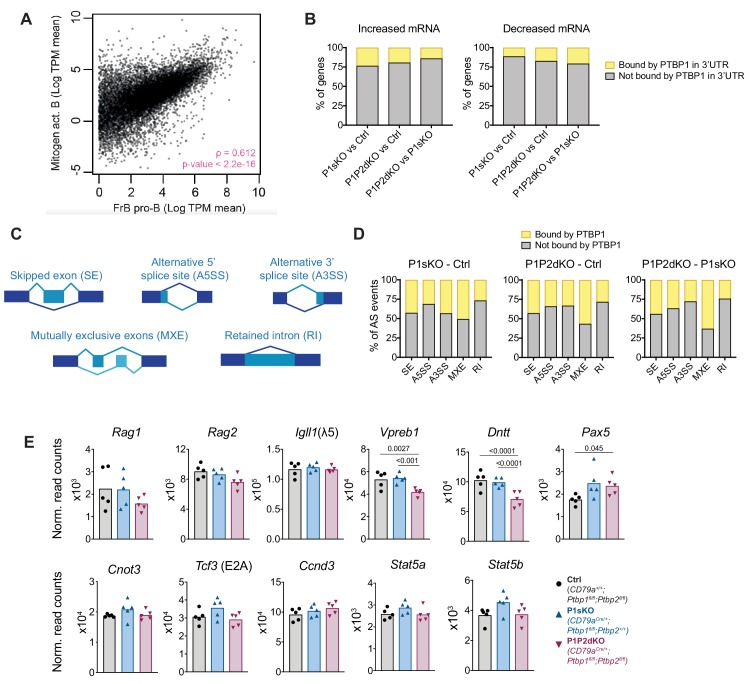
Transcriptome analysis of pro-B cells.(A) Transcriptome correlation in mitogen-activated primary B cells and FrB pro-B cells. Dots show mean values of TPMs (Transcripts Per Million) from four or five biological replicates in mitogen-activated B cells and pro-B cells, respectively. Correlation was calculated with Spearman's rank correlation rho on genes with > = 1 TPM in pro-B cells and >0 TPM in mitogen-activated B cells (12545 genes). 681 genes had 0 TPMs in mitogen-activated B cells and > = 1 TPM in pro-B cells. (B) Proportions of genes with differences in mRNA abundance for the indicated pairwise comparisons that are bound by clusters of PTBP1 (iCLIP data) on their 3’UTR (Figure 4—source data 1). (C) Different types of alternative splicing events analysed with rMATS. (D) Proportions of AS changes between the indicated comparisons that are bound by at least one PTBP1 cluster on the alternatively spliced exon or in its vicinity (500 nucleotides upstream or downstream of the alternatively spliced exon, on the constitutive flanking exons, on the 500 nucleotides downstream of the upstream constitutive exon or on the 500 nucleotides upstream of the downstream constitutive exon) (Figure 4—source data 2). (E) mRNA abundance of known regulators of B cell development in pro-B cells. DESeq2 normalised read counts of the indicated genes. DESeq2 calculated padj values are shown when < 0.05. Bars show arithmetic means. Each dot shows data from an individual mRNAseq biological replicate.